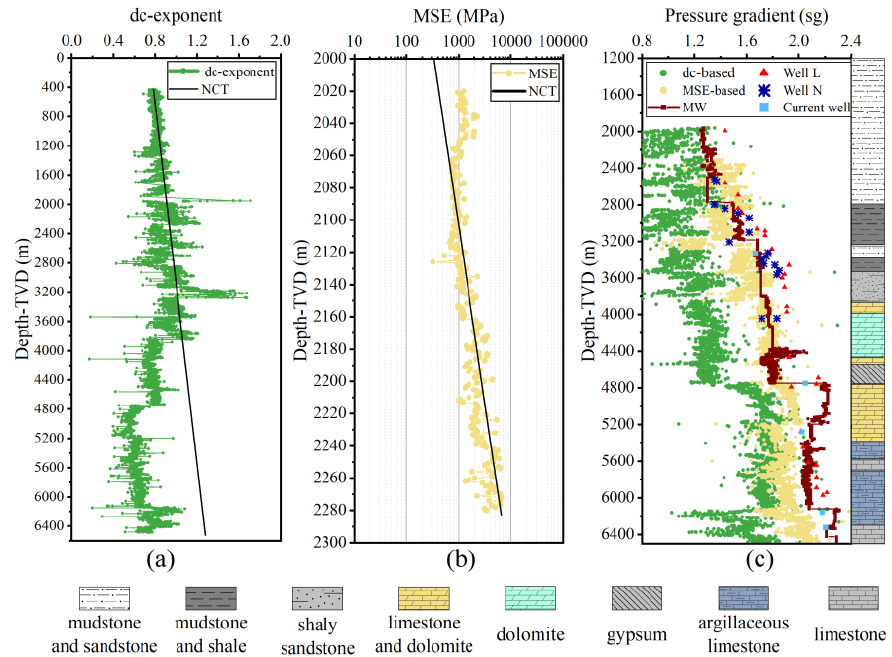
Figure 5. Comparison of the MSE-based method and dc-exponent method for the pore pressure detection in well M. ( a ) The NCT of dc-exponent method; ( b ) the NCT of MSE-based method; ( c ) comparison of pore pressure detection between the dc-exponent method and MSE-based method.